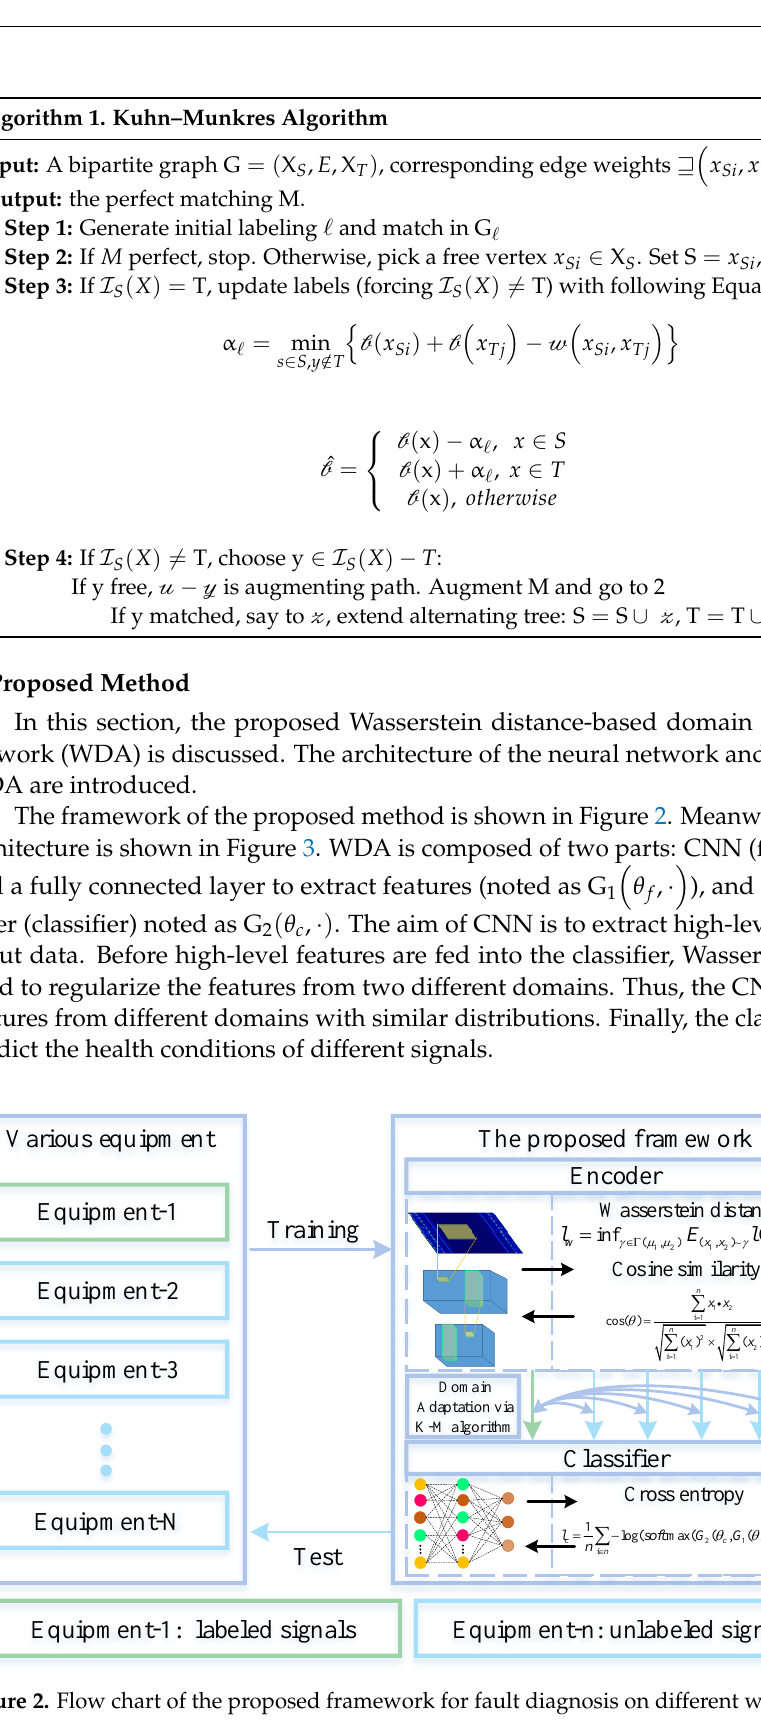
Figure 2. Flow chart of the proposed framework for fault diagnosis on different working equipment. During the training phase, we narrow the gaps between the distributions. At the test phase, the WDA directly predicts the health conditions of unlabeled signals.